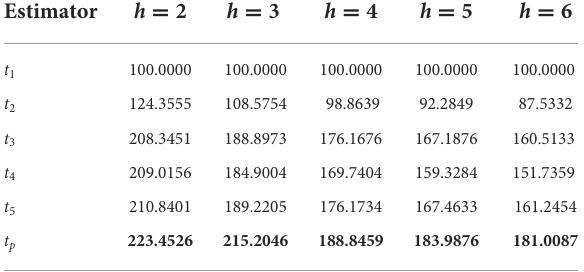
TABLE 8 PRE of different estimators with respect to t 1 for Population